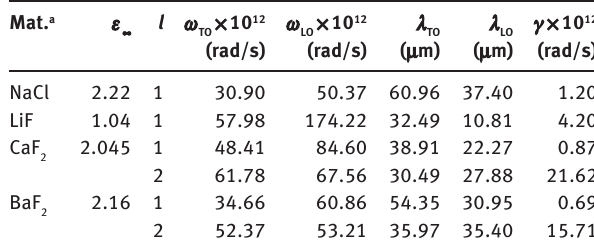
Table 1: Ionic crystals: permittivity model parameters corresponding to Eq. (26) for some common ionic